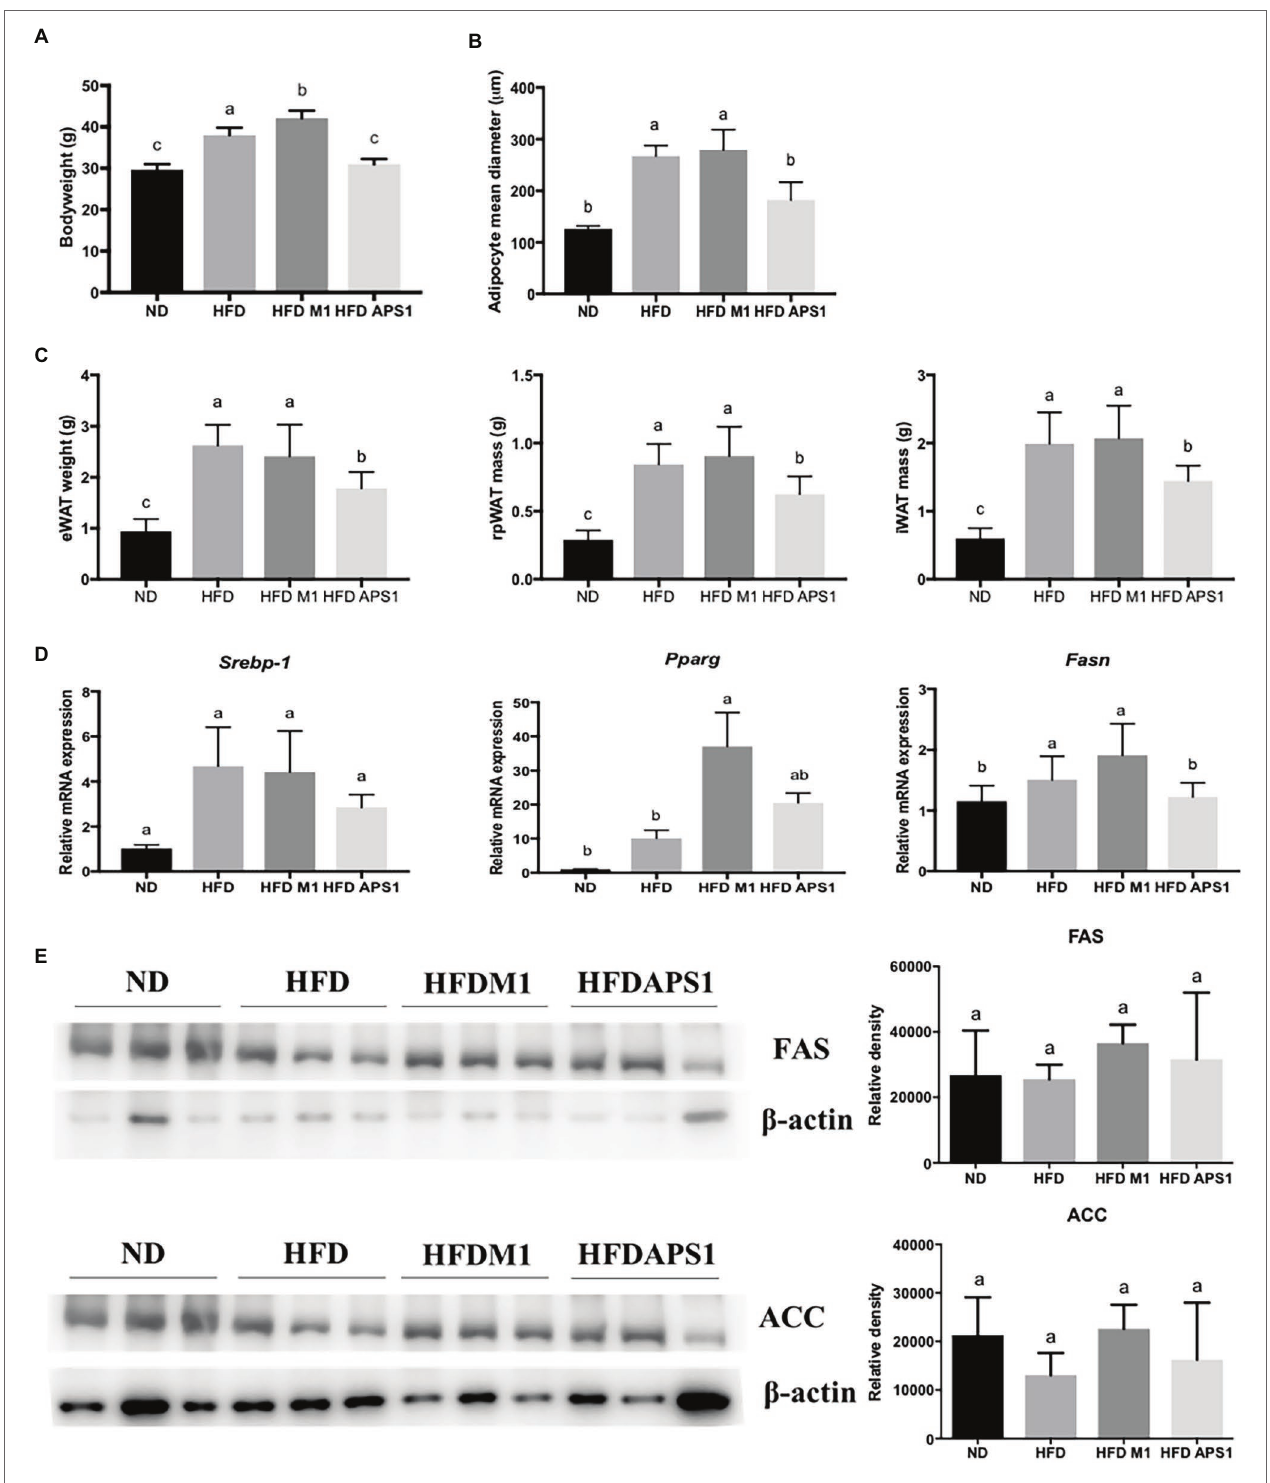
FIGURE 2 | M1 and APS1 regulate fat hypertrophy and mRNA expressions of adipogenesis in mouse adipose tissue. M1 and APS1 interventions modulated (A) body weight; (B) the mean diameters of epididymal white adipose tissue (eWAT) adipocytes; (C) the weight of eWAT, rpWAT and iWAT; (D) adipogenesis- related mRNA expressions in mouse eWAT; (E) Western blot analyses of fatty acid synthase (FAS) and acetyl-CoA carboxylase (ACC) in adipose tissue. Relative quantification of gene expressions was performed using the comparative Ct method with normalization to GAPDH. Results were expressed as fold difference relative to a relevant control sample. Data are expressed as the mean ± SEM of 8–10 mice per group. Labeled means without a common superscript letter differ, p <